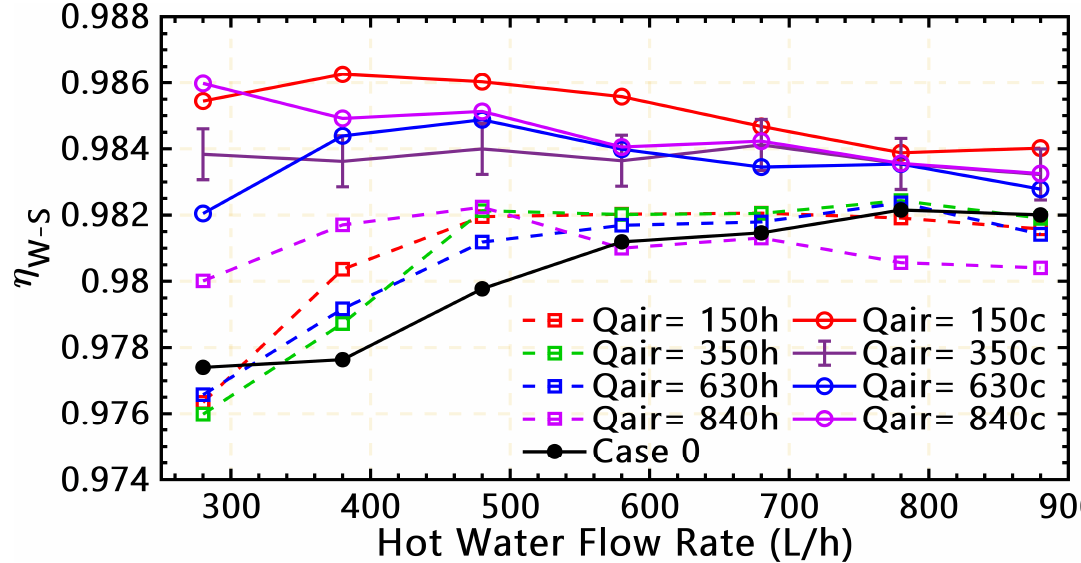
Figure 13. The variations of η W − S at different Q h and Q air at different operating conditions.